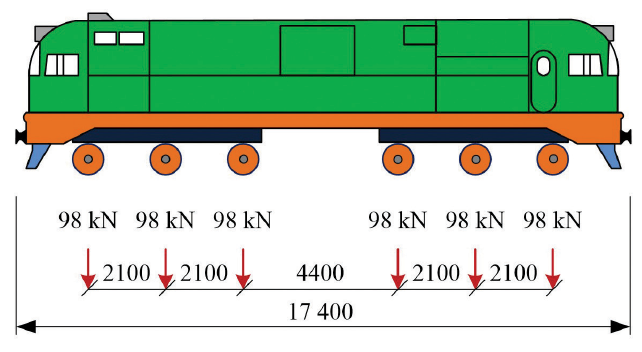
Figure 6. Scheme of a three-axle locomotive of the series 2M62 Note: units in